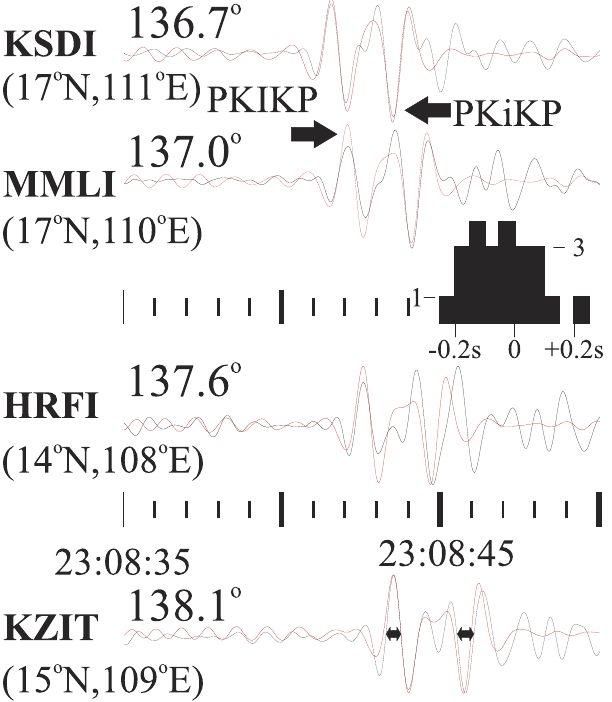
Figure 1. Recordings at some Israel Seismic Network stations of 2013, April, 13 th Vanuatu event. A zero- phase Butterworth band-pass filter in the range 0.7 to 2 Hz has been applied both to the broad-band vertical recordings (black) and to the corresponding synthetics (red). Epicentral distances are shown. The location of the PKIKP bouncing points (indicated in the parenthesis) is in the very proximity of the central meridian (110°E longitude) of the quasi-Eastern Hemisphere. Yet, all the differential times are very close to zero. The inset histogram is obtained for the 23 differential times at the stations in Turkey for the same earthquake, and for the 2017, April, 5 th Vanuatu event. The bouncing points are in the same area. The mean of the differential times is − 0.05 + / − 0.05 seconds (95% confidence error), significantly different from a value of 0.65 seconds obtained from a velocity perturbation around 1% (in respect to ak135 model) as suggested from the q-EH model 49 . The time windows used to obtain the differential times at KZIT station are approximately indicated by the double horizontal